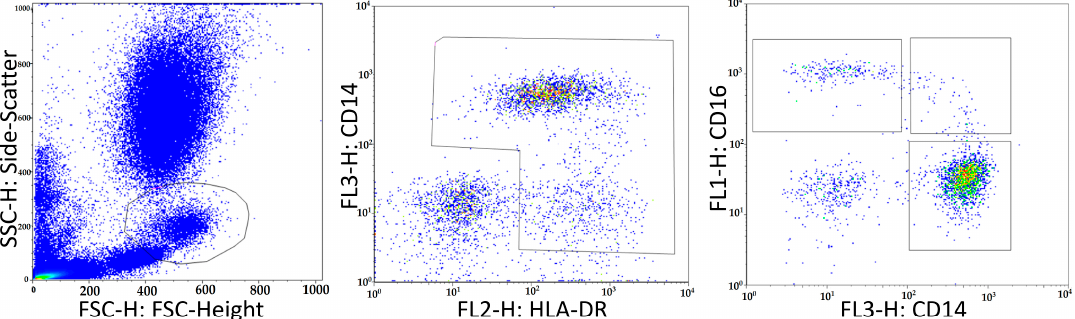
Figure 3. Gating strategy for FACS-analysis of monocyte subset counts. First, total monocytes were gated in a FSC/SSC-plot; Afterwards, in a CD14/HLA-DR-Plot HLA+ cells were gated for exclusion of lymphocytes; Finally, the three monocyte subsets could be measured in a